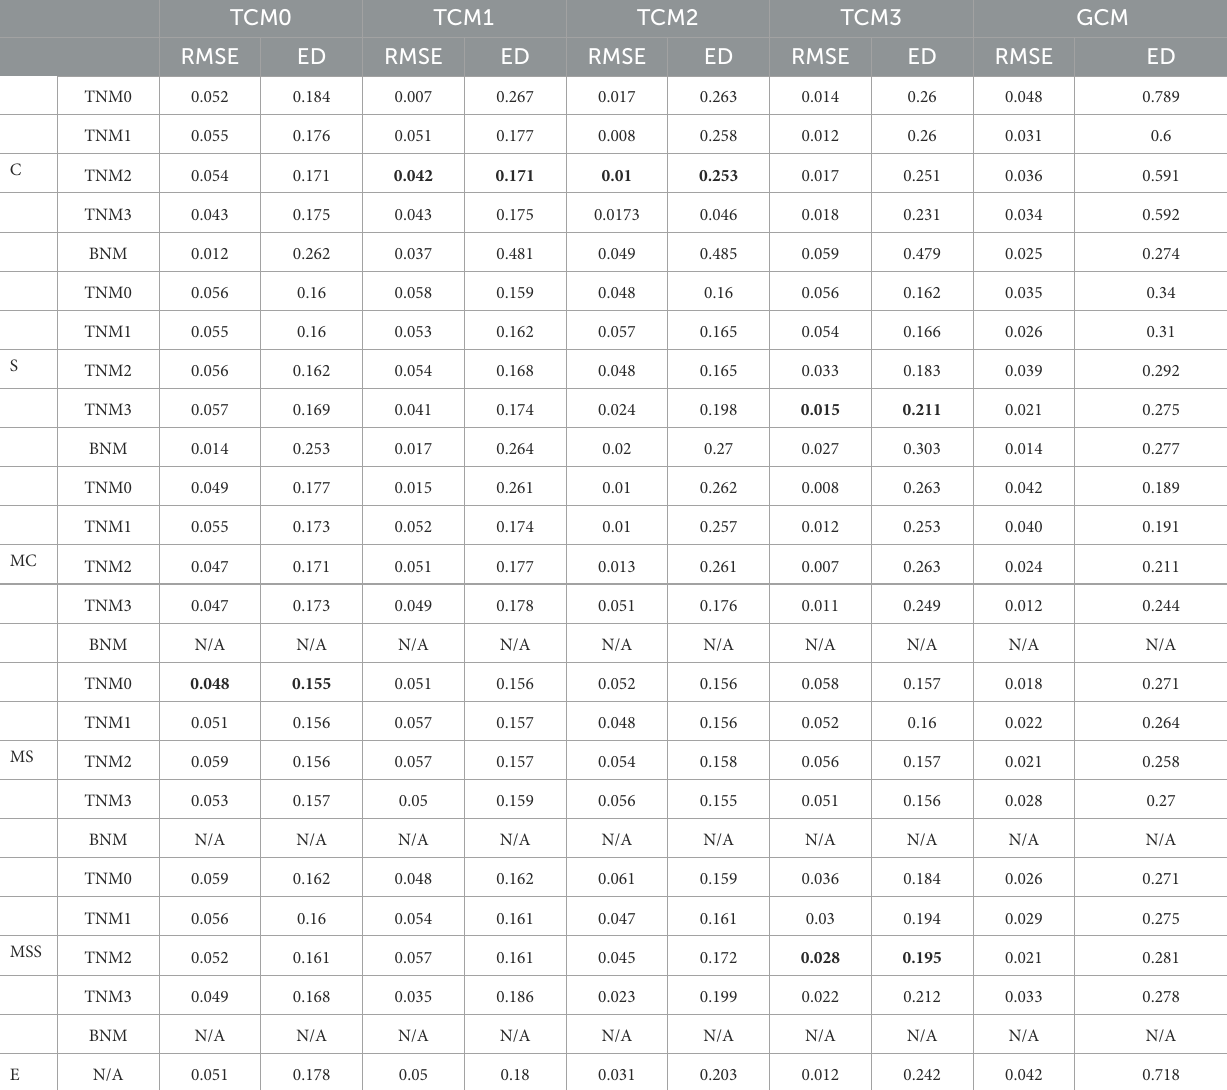
TABLE 1 The tradeoff between selection bias (distance) and undesirable spillover (RMSE) in CMatch variants in the Cora